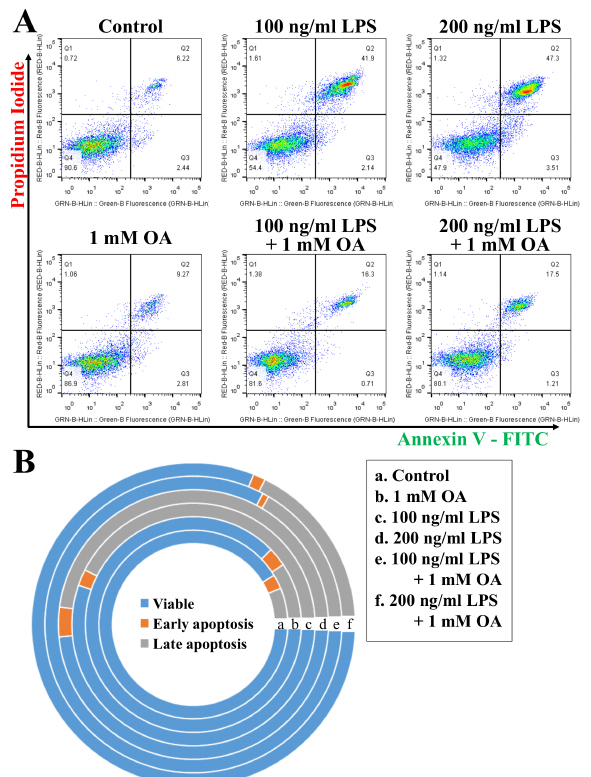
Figure 2. OA treatment alleviates LPS-induced apoptosis in Raw264.7 cells. (A) Flow cytometry analysis of annexin-V / PI staining in Raw264.7 cells after various treatments. The proportions of cells were included in each quadrant. (B) Summary of (A) on double